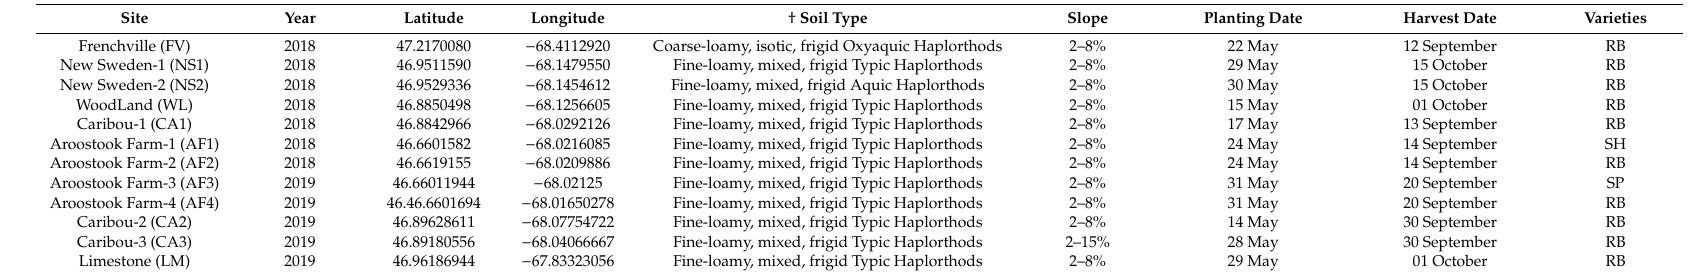
Figure 1. Climate data during the potato-growing season: a monthly temperature average (°C) and precipitation (mm). Source: National Oceanic and Atmospheric Administration, USA [26]. Table 1. Sites